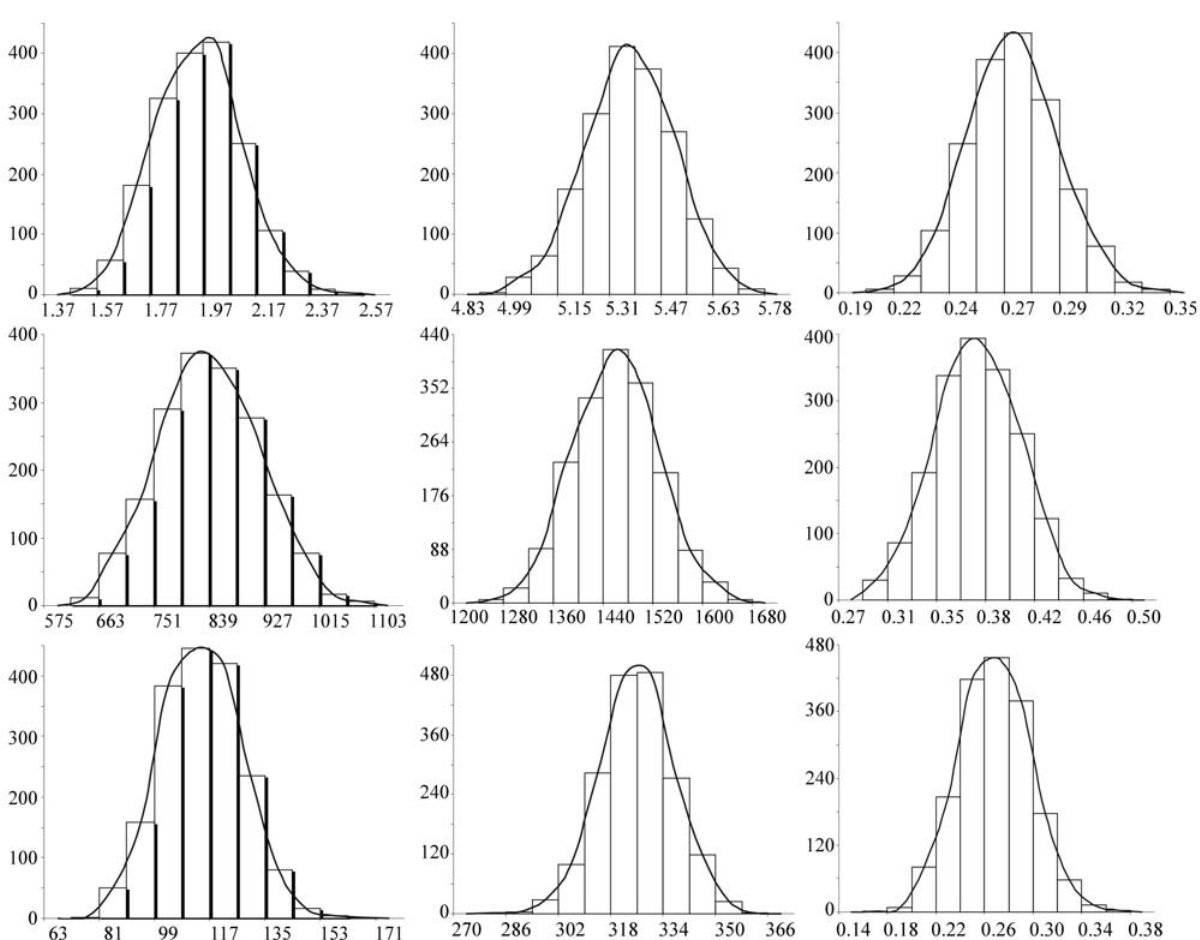
Figure 1 - Posterior density distributions of additive genetic variance ( σ 2 a ), residual variance ( σ 2 e ) and heritability (h 2 d ) for age at first calving (upper), adult weight (central) and cumulative productivity (lower) by single-trait